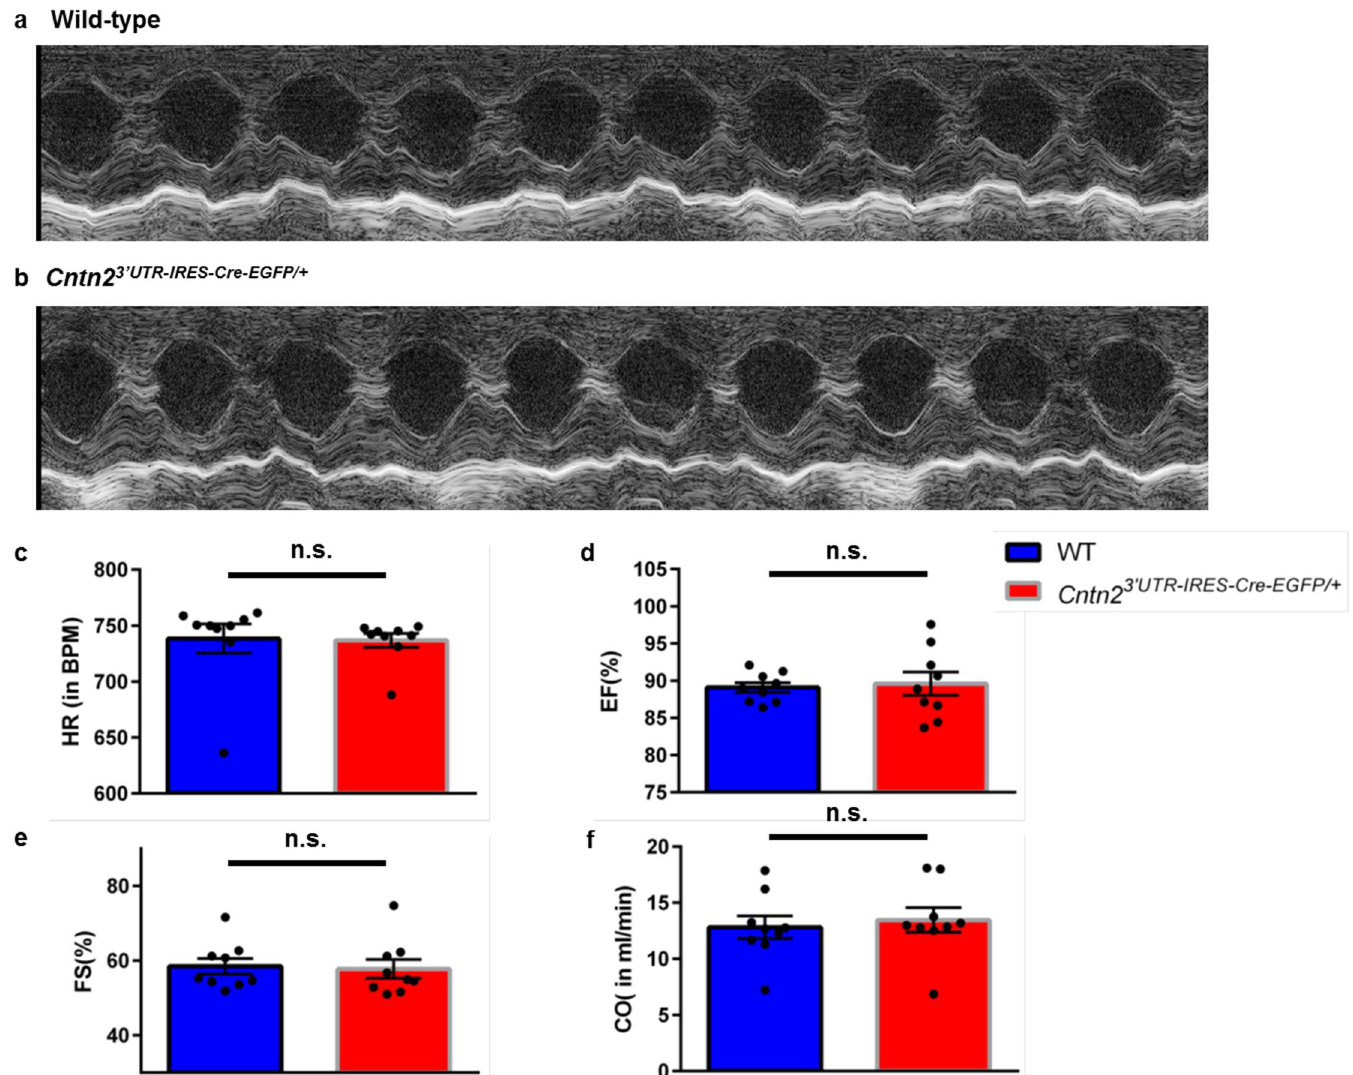
Fig 5. Cardiac mechanical function is preservedin Cntn2 3’UTR-IRES-Cre-EGFP/+ mice. (a-b) M-mode echocardiography was performed in consciousmice to analyzeheart function parameters in P42 (a) wild-type(WT) and (b) Cntn2 3’UTR-IRES-Cre-EGFP/+ mice. Representative traces show normalheart function in both groups. (c) Heart Rate (HR) in Beats Per Minute (BPM), (d) Ejection Fraction (EF) as a percentage,(e) Fractional Shortening(FS) as a percentage, and (f) CardiacOutput (CO) in millilitersper minute were calculatedfor n = 9 animalsin both groups. Black circles represent individualWT and Cntn2 3’UTR-IRES-Cre-EGFP/+ mice used in this study. Blue and red bars represent mean values of each parameter in WT and Cntn2 3’UTR-IRES-Cre-EGFP/+ mice, respectively. No statistically significantdifferences were observedbetweengroups. ns, not significant.